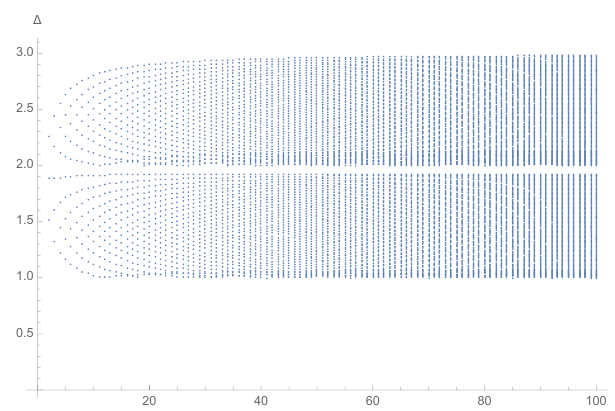
Figure 3 . Dimensions of the ‘single-trace’ operators form a band between 1 and 3.